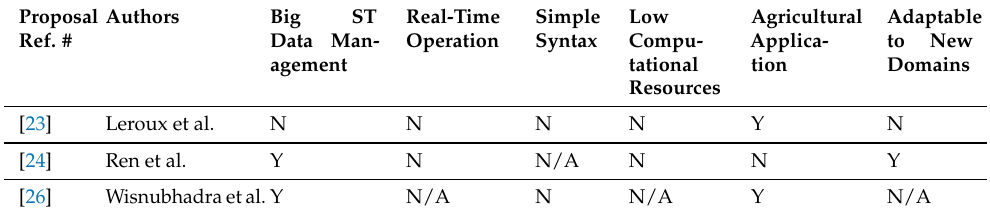
Table 1. A comparison between the most relevant related proposals. Proposal Ref.